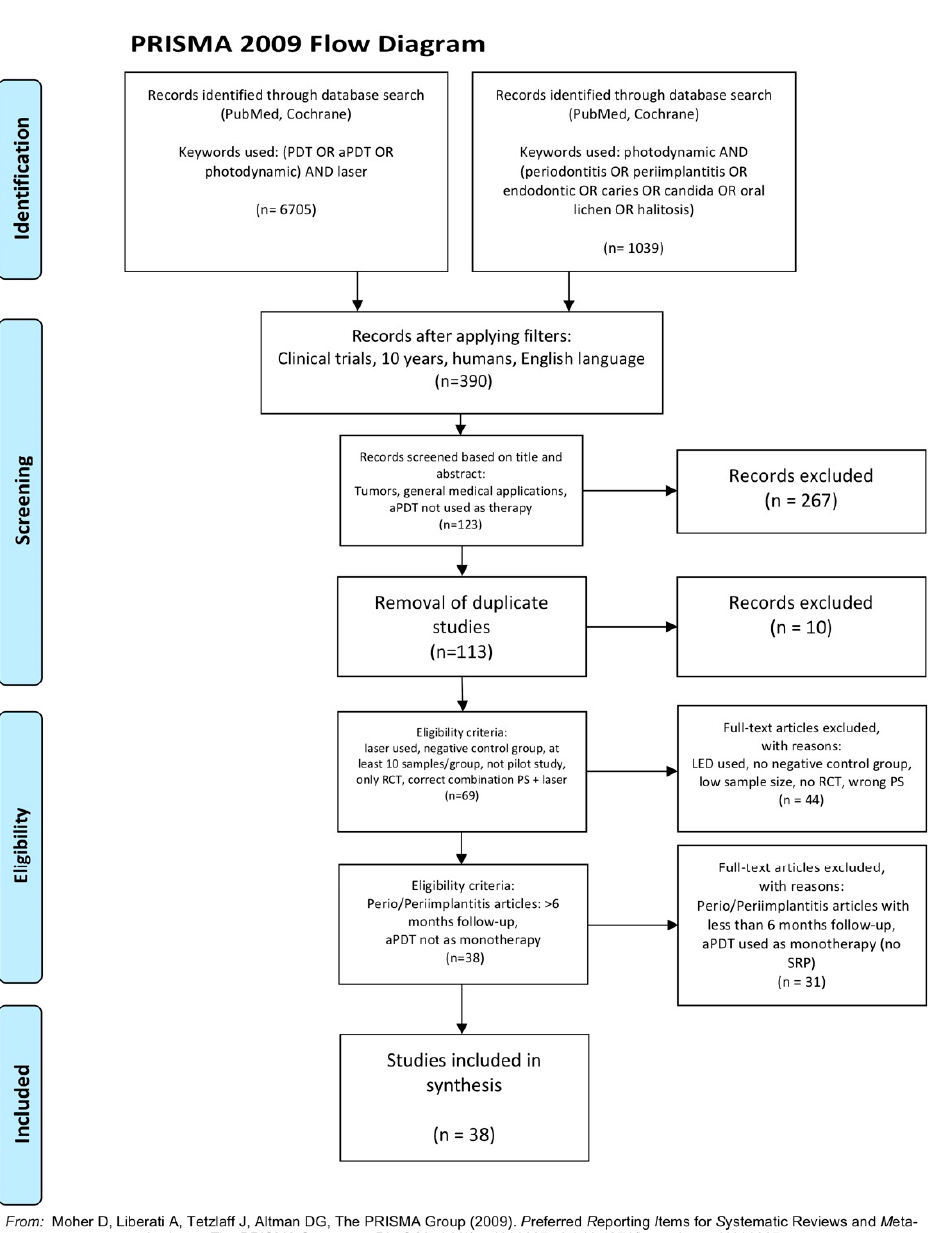
Figure 1. PRISMA flow-chart of selected criteria for the included article reports